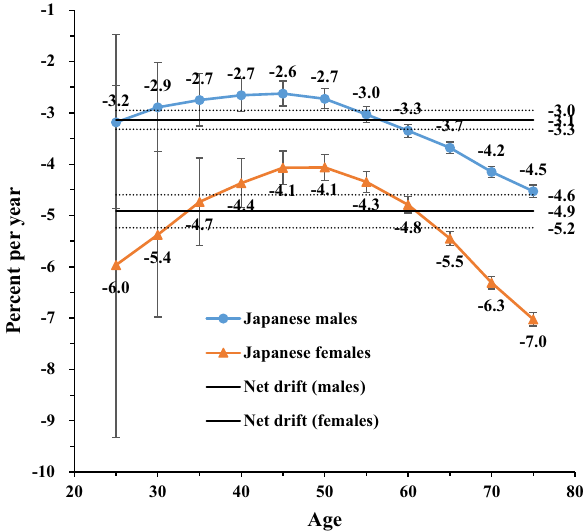
Figure 3. Local drift with net drift values for high SBP-attributable stroke mortality in Japan. Age group- specific annual percent change (local drift) with the overall annual percent change (net drift) in high- sodium-intake-attributable stroke mortality rate. Net drift values are depicted as solid lines with dashed lines representing their 95% CIs. Error bars represent the 95% CIs for the local drift values. Japanese men